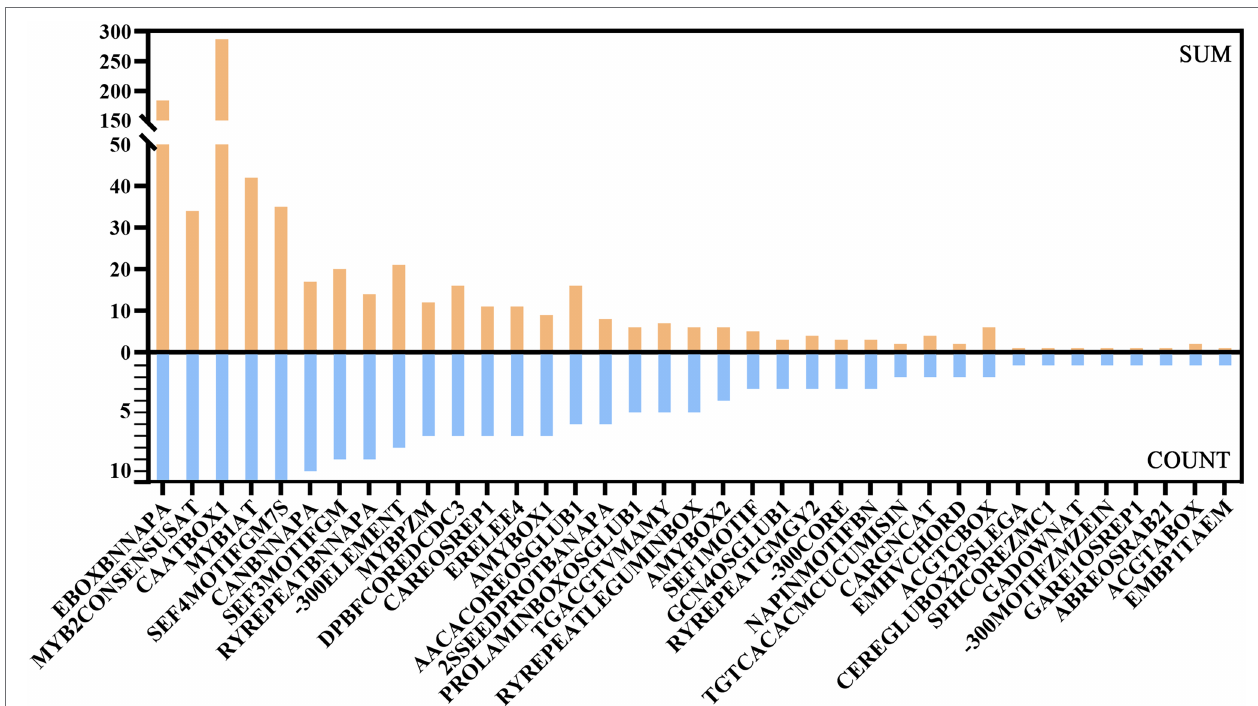
FIGURE 6 | Cis-acting elements related to seeds from PLACE prediction results upstream of GbPLATZ s. SUM represents the total number of cis-acting elements upstream of the 11 GbPLATZ s. COUNT represents the number of GbPLATZ s whose upstream regions contain the respective